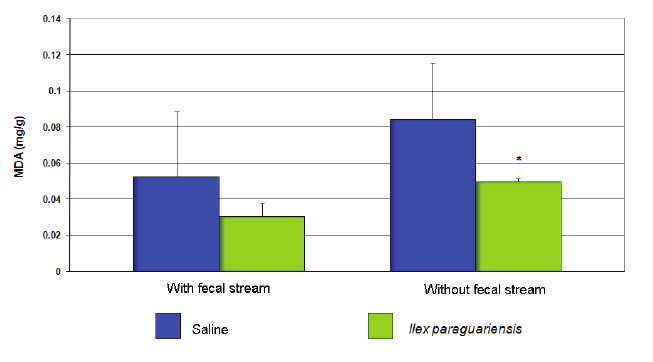
FIGURE 4 – Tissue levels of MDA comparing colon segments with and without fecal stream from animals that underwent irrigation for two weeks with aqueous extract of Ilex paraguariensis or saline. **significant; p<0.05. Mann Whitney test.